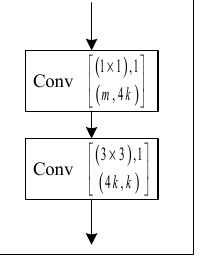
Figure 3. The structure of each layer.